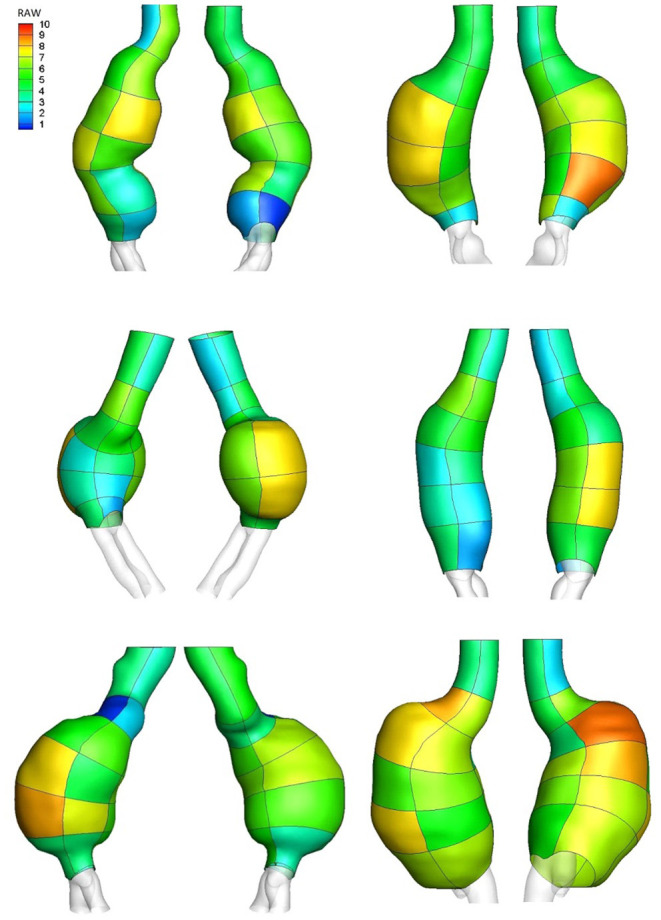
RAW distribution on regions defined on the external wall of AAA case examples.